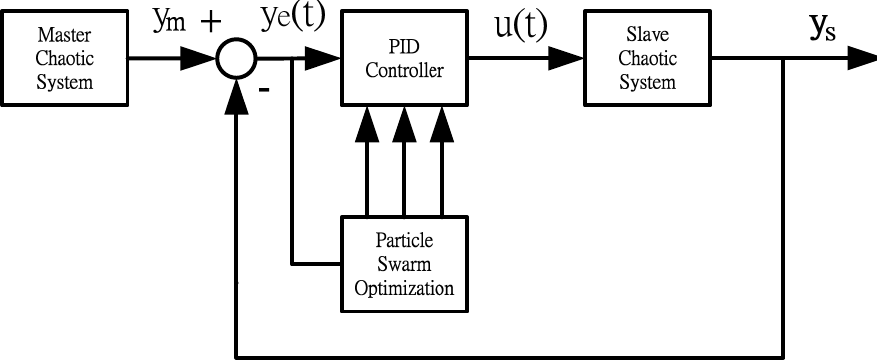
Figure 1. Block diagram of PID controlled chaotic synchronization system of the PSO